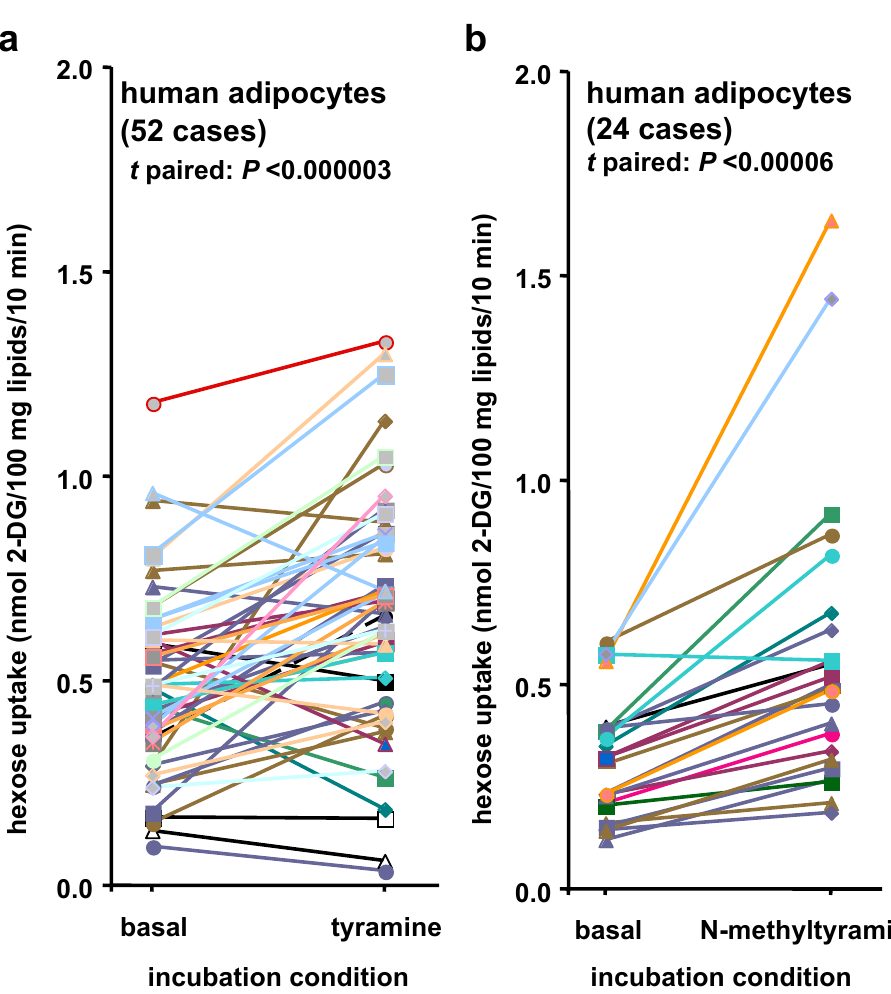
Figure 1. Influence of tyramine and N -metyltyramine (NMT) on hexose uptake in human adipocytes. ( a ) For each individual adipocyte preparation from a total of 52 subjects (one color per individual), the comparison is shown between 2-deoxyglucose uptake (2-DG) determined after 45 min incubation without (basal) or with 1 mM tyramine. Significant stimulatory influence of tyramine was validated by t -paired analysis ( p < 0.000003). ( b ) Same t -paired analysis between spontaneous 2-DG uptake (basal) and in response to 1 mM NMT ( N -methyltyramine) is shown for a total of 24 other individuals. Significant difference between basal and NMT-stimulated uptake was found at p < 0.0006.